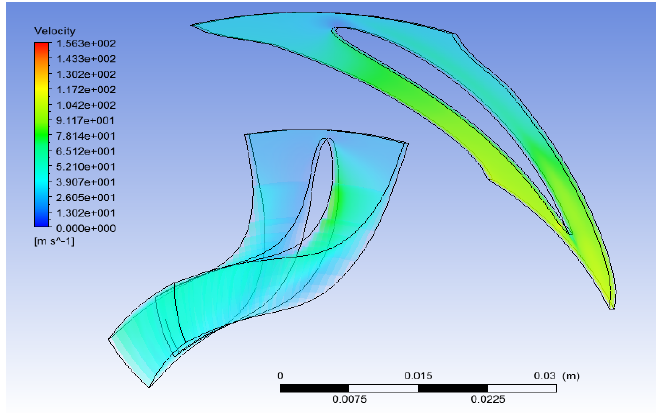
Figure 31. CFD study results: Velocity volume rendering